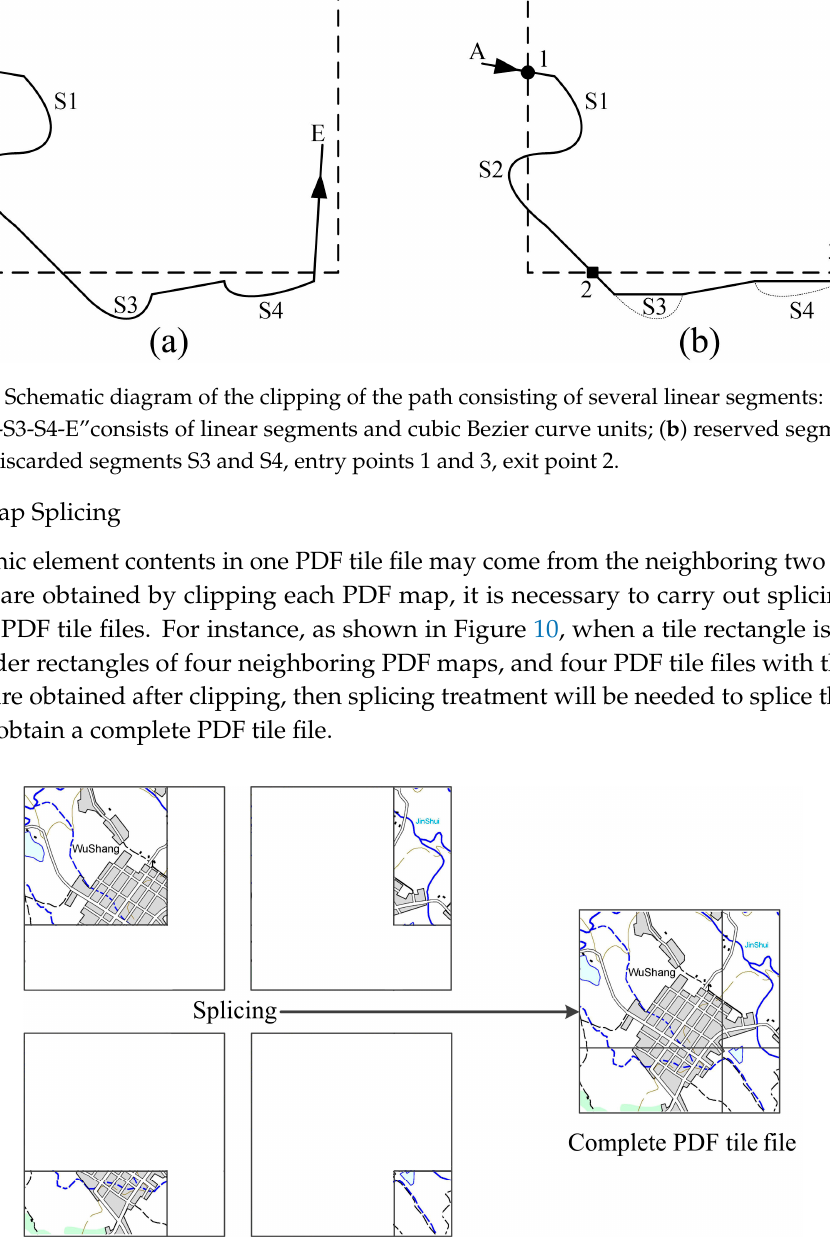
Figure 10. Same tile-encoded PDF tile map splicing.